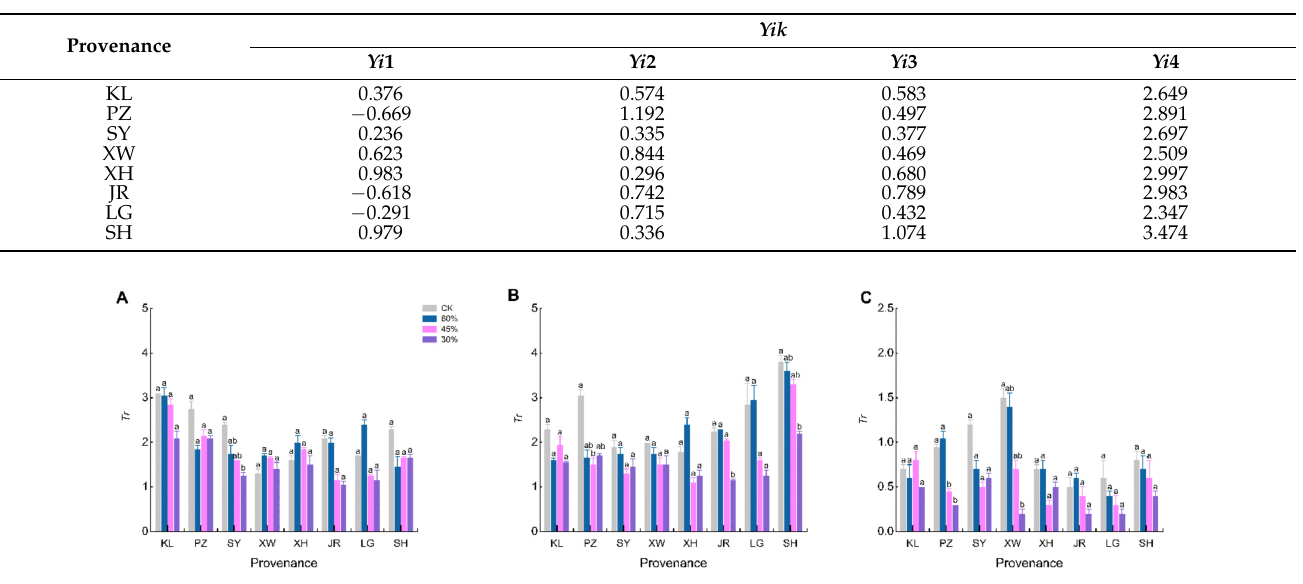
Table A9. The value of the comprehensive indexes of the different provenances under severe drought stress.